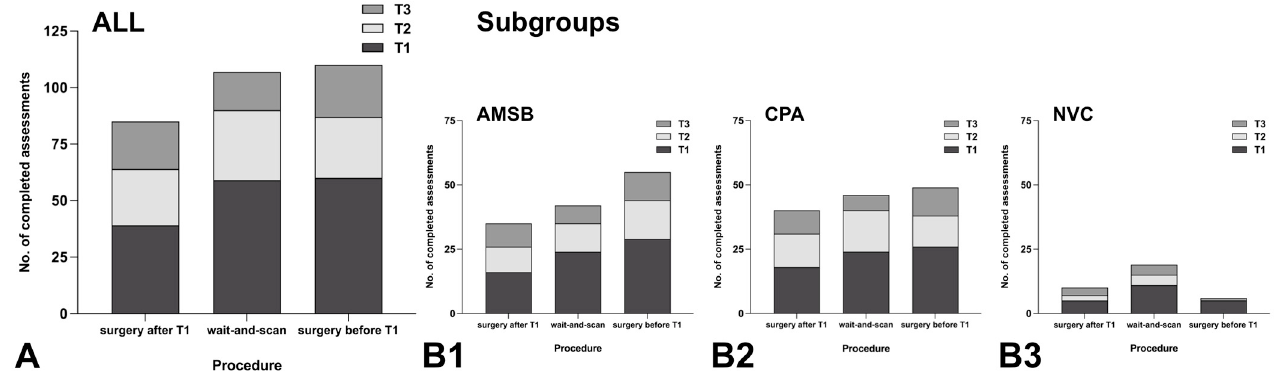
Figure 3. Evaluation of the response rate to PROMs depending on subgroup and neurosurgical procedure. ALL = total group, AMSB = subgroup “anterior and middle skull base”, CPA =